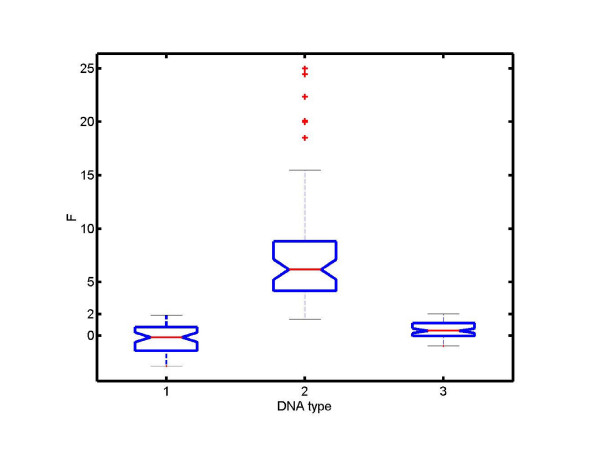
Separation of regulatory DNA. Separation of regulatory DNA (column 2) from coding (column 1) and non-coding, non-regulatory (column 3) due to the fluffiness coefficient F (Y-axis). Box-plot of the Fluffiness (Y-axis) index for the three functional regions.